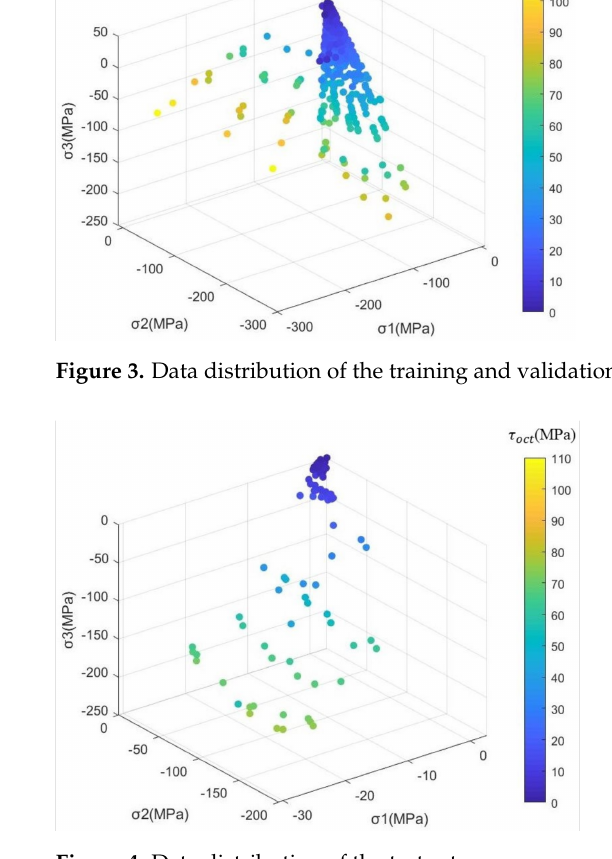
Figure 4. Data distribution of the test set.